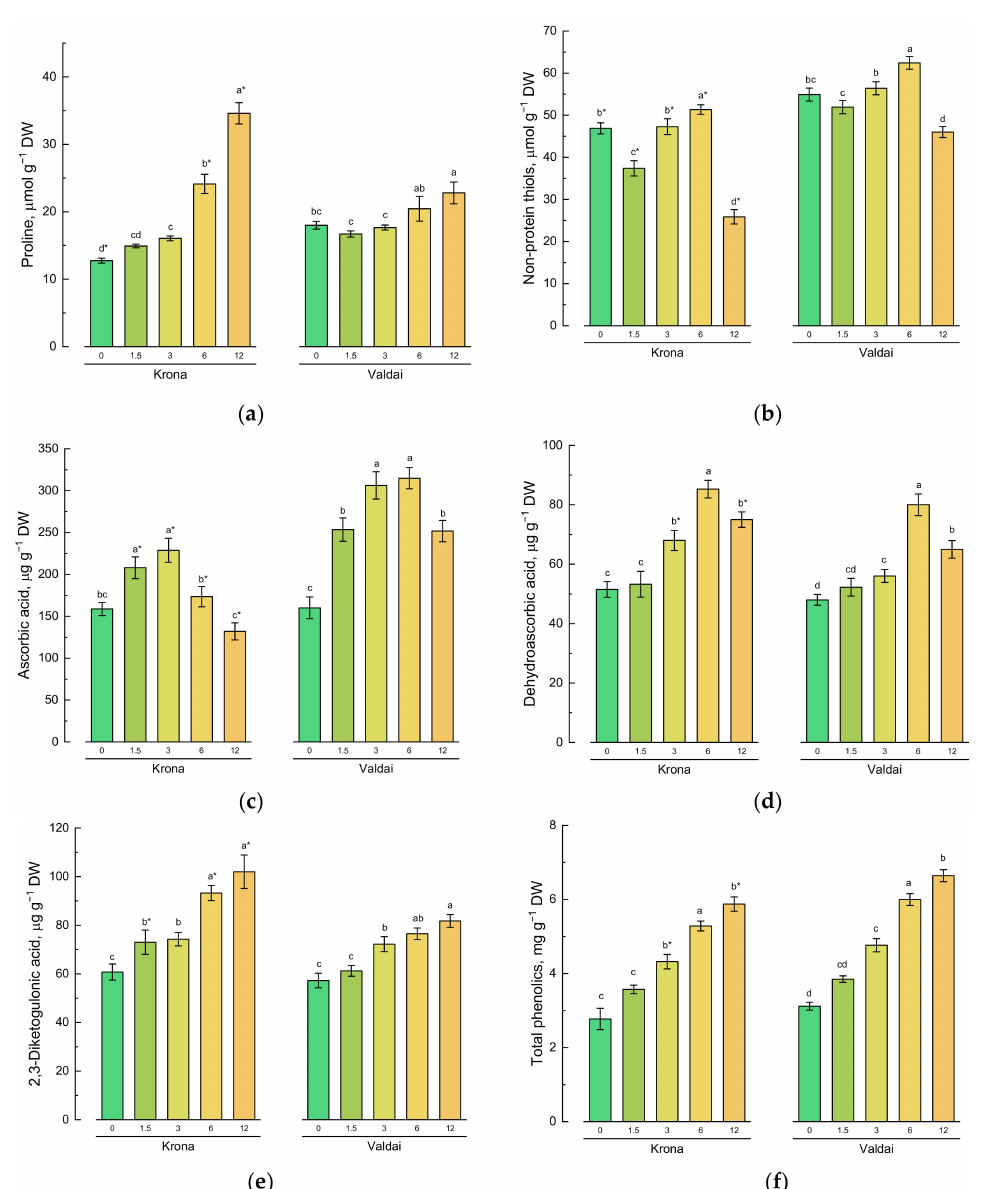
Figure 3. Effect of soil pollution with crude oil (given on X -axis in %) on contents of non-enzymatic antioxidants: ( a ) proline, ( b ) non-protein thiols, ( c ) ascorbic acid, ( d ) dehydroascorbic acid, ( e ) 2,3-diketogulonic acid, and ( f ) total phenolic compounds in shoots of two rye varieties. Different lower-case letters indicate significant differences between plants by oil concentration in the soil for each variety separately, and asterisks * indicate significant differences between rye varieties at p ≤ 0.05 based on post hoc Tukey’s test ( n =